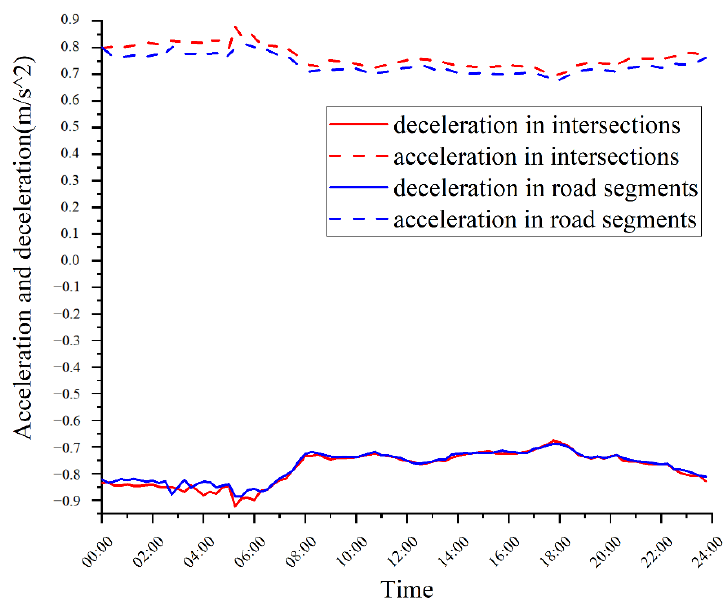
Figure 3. Average acceleration and deceleration at intersections and in road segments.